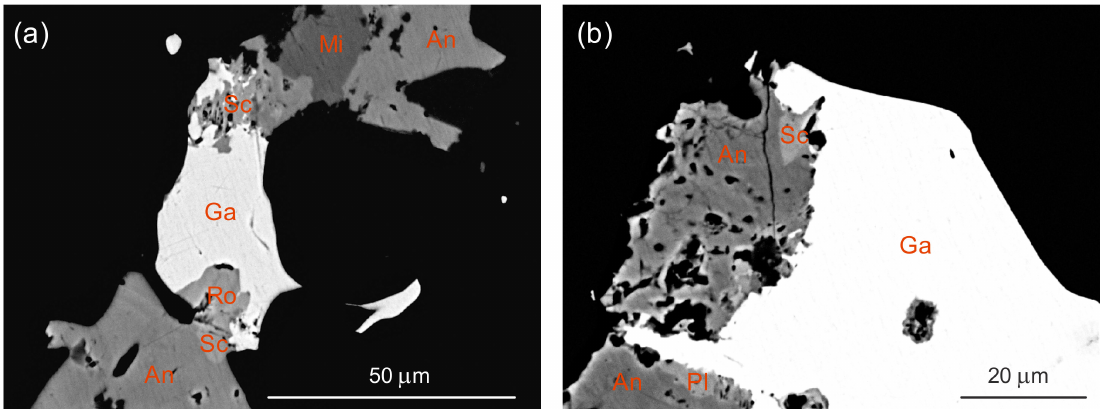
Figure 25. ( a ) Robinsonite (Ro) and scainiite (Sc) in association with galena (Ga), miagyrite (Mi), and andorite VI (An); ( b ) plagionite (Pl) and scainiite (Sc) associated with galena (Ga), and andorite VI (An); both back-scattered electron (BSE)